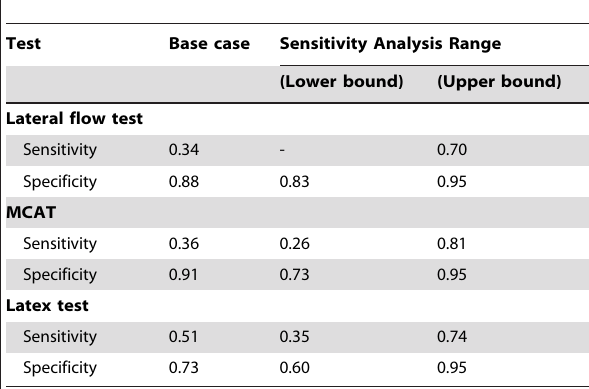
Table 2. Test performance using acute sera